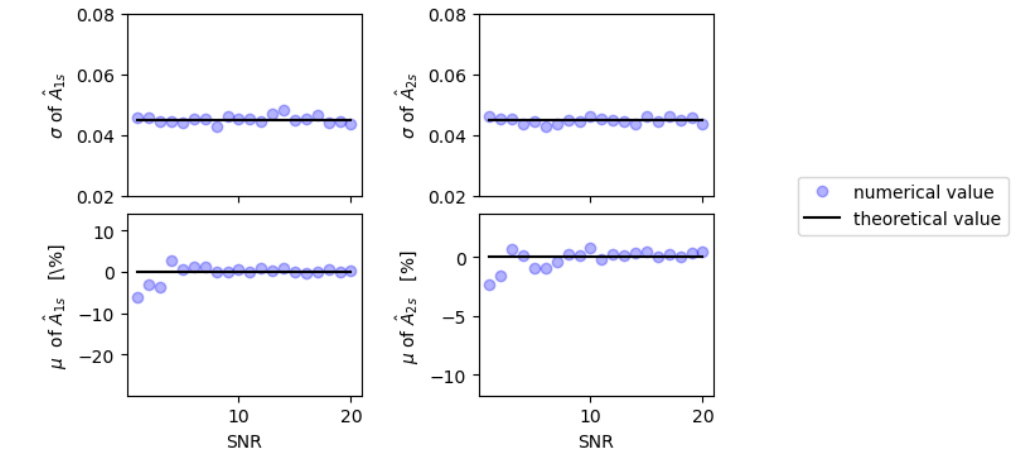
Figure 5. Bias and standard deviation of dipole amplitudes: A 1 S ( left ) and A 2 S ( right